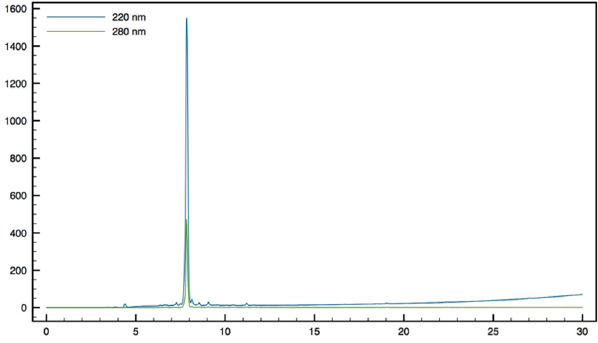
Figure 11. HPLC profile of Trp- β 2, h bis-Orn-OMe 8 . Figure 11 . HPLC profile of Trp- β 2, h bis-Orn-OMe 8 . Figure 11 . HPLC profile of Trp- β 2, h bis-Orn-OMe 8 .